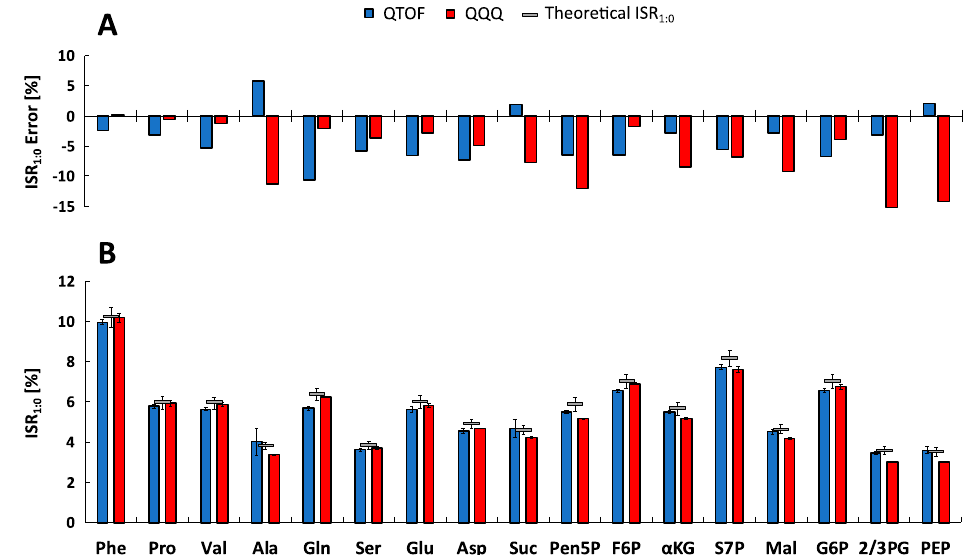
Figure 3. Evaluation of m+1 / m+0 Isotopologue Ratios (ISR 1:0 ). ( A ) Experimental metabolite-specific mean ISR 1:0 values ( n = 5) determined by the QTOF-HRMS (blue) and QQQ-SIM (red) systems in defined non-labeled mixtures of reference standards and theoretical calculated ISR 1:0 (grey) [29]. ( B ) Corresponding relative ISR 1:0 errors of the experimental compared to the theoretical ratio for both systems. See Tables S1–S4 for the full names of abbreviated